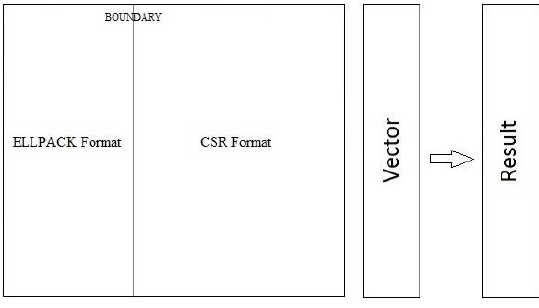
Figure 2. The proposed format.